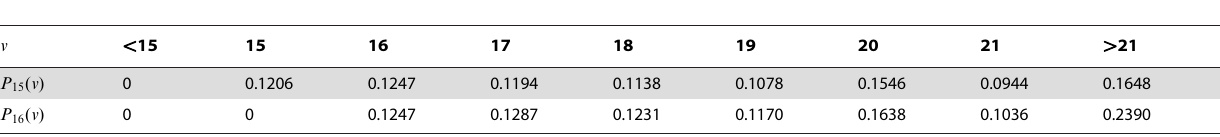
Table 3. Probability distribution of hand values P s ( v ) after drawing the last